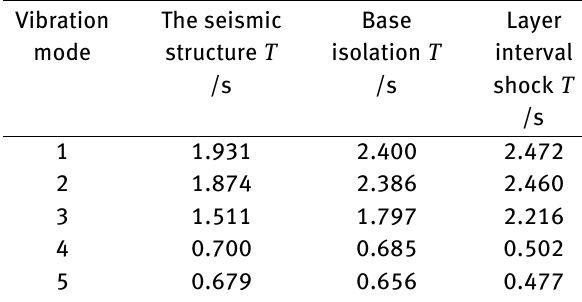
Table 2: Period and mass participation coeflcient Vibration